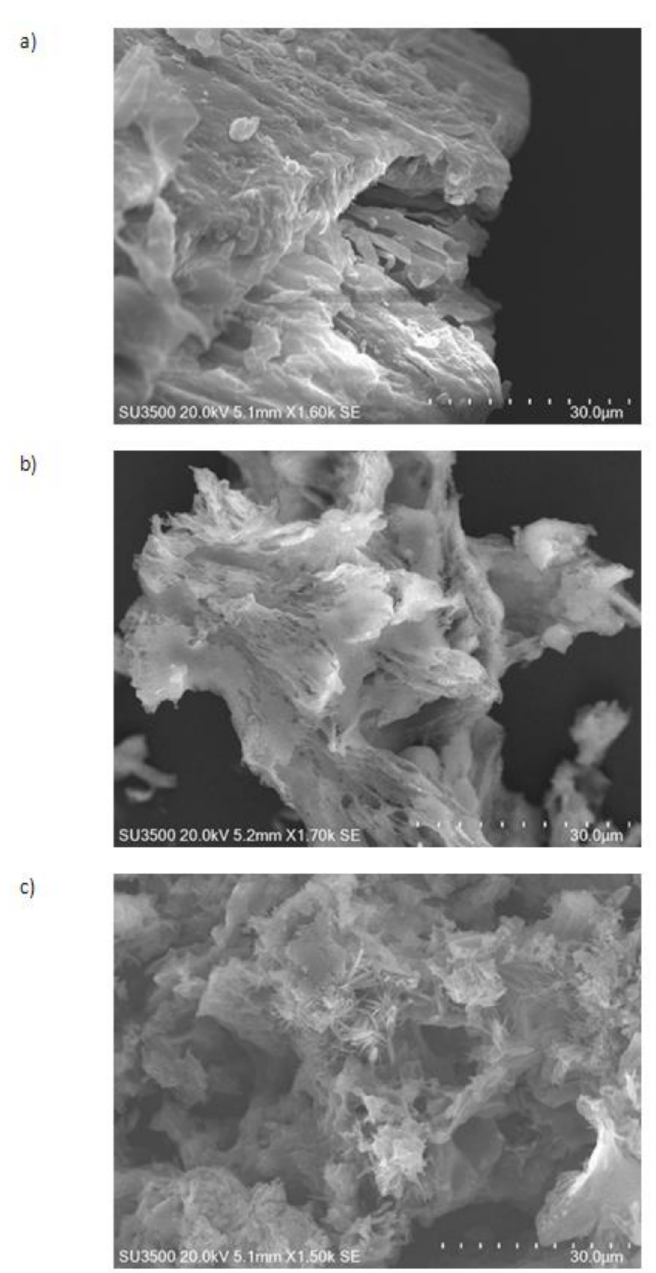
Figure 2. SEM images of BSG: ( a ) original untreated sample; ( b ) milled sample; ( c ) cavitated